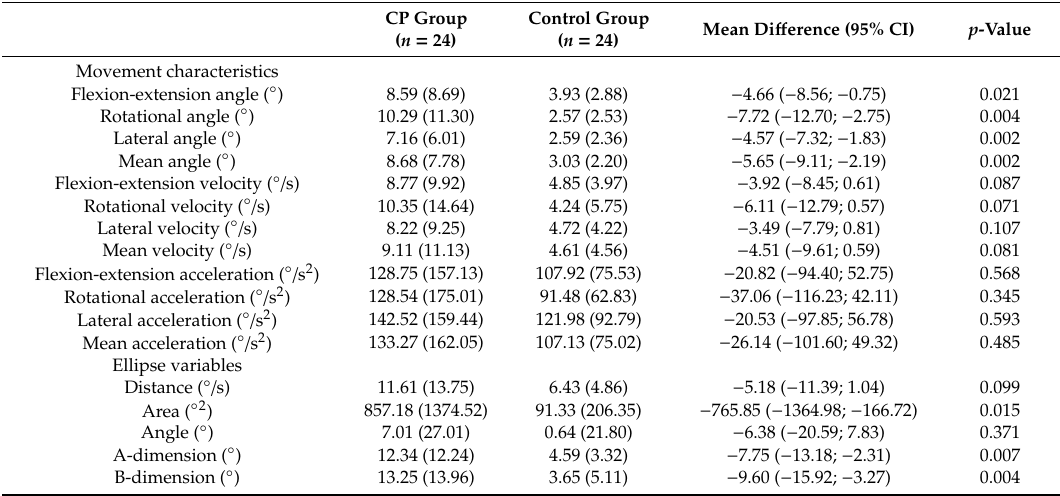
Table 2. Comparison of the new test results obtained on the first day between the CP and control